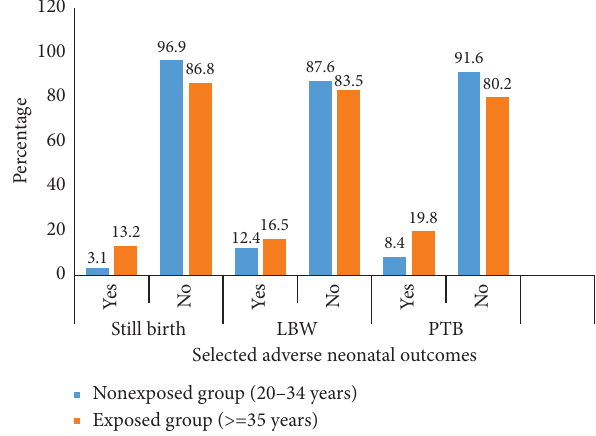
Figure 2: Distribution of selected neonatal adverse pregnancy outcomes over grouped maternal age in Debre Markos referral hospital, Northwest Ethiopia, 2019 ( N E � 303 and N Ne �